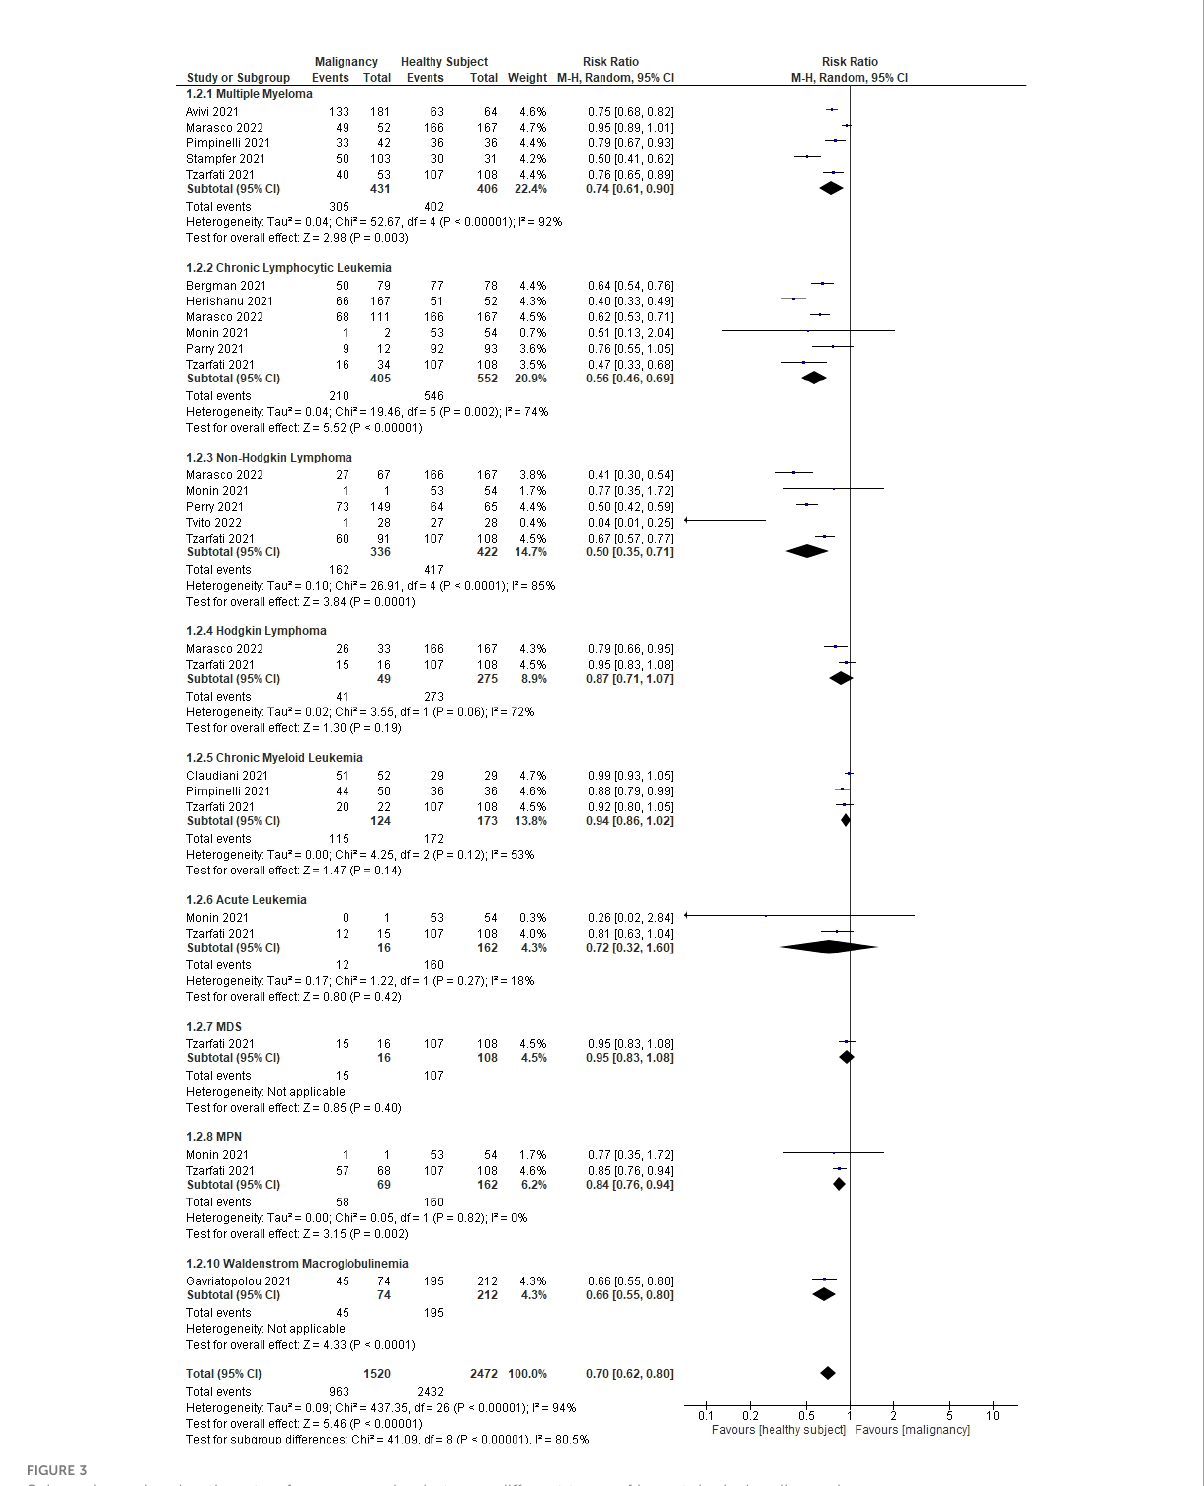
FIGURE 3 Sub-analyses showing the rate of seroconversion between different types of hematological